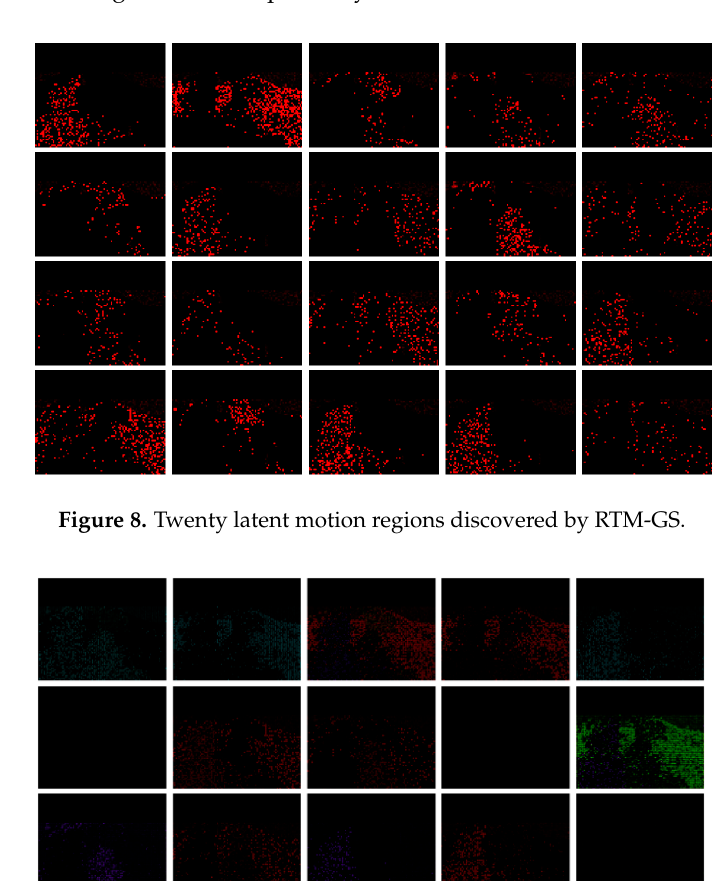
Figure 7. Comparative results of ROC. ( a ) Comparative results on NLL. ( b ) Comparative results on r_NLL.